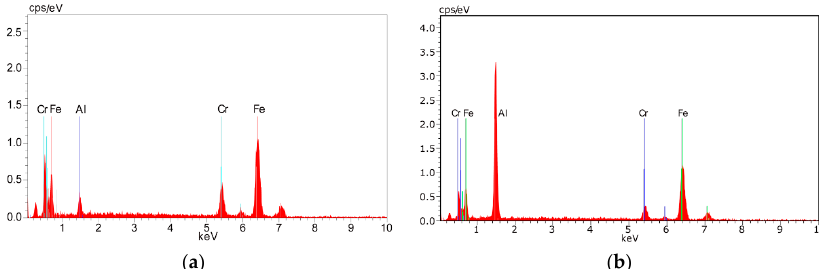
than those of the FeCrAl coating. From a combination of the cross-sectional images, XRD, and EDS